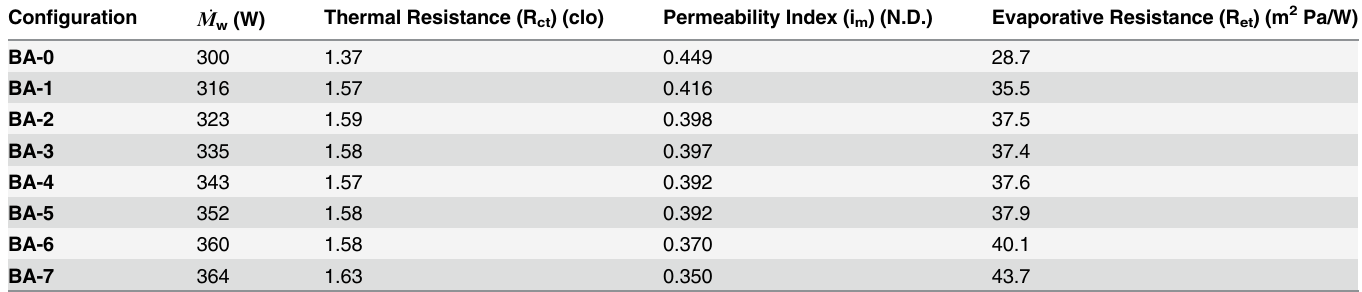
Table 2. Metabolic cost estimated for walking at 1.34 m/s and biophysical measures at 0.4 m/s. Con fi guration M _ w